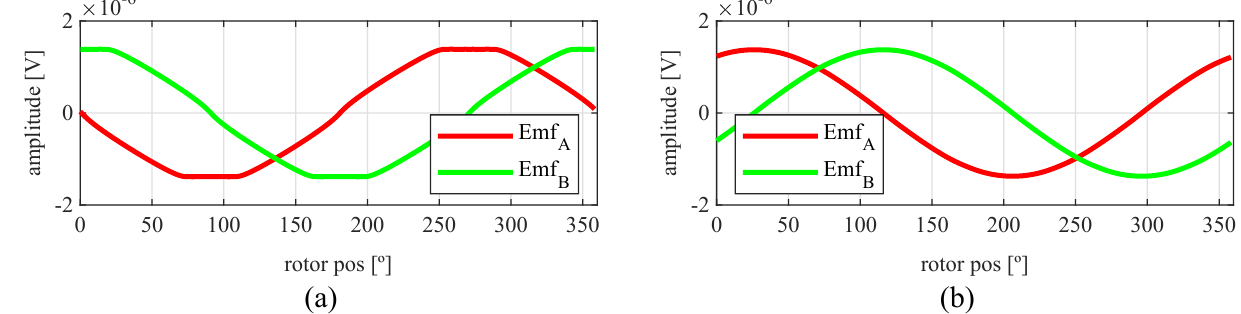
Figure 30. Toroidal slotless resolver EMFs skewed for the least THD ( a ) before skew and ( b ) with skew. Comparing the skewed signals with the ideal sine and cosine, unlike the previous topologies, it can be seen that there were almost no observable differences (Figure 31). How-